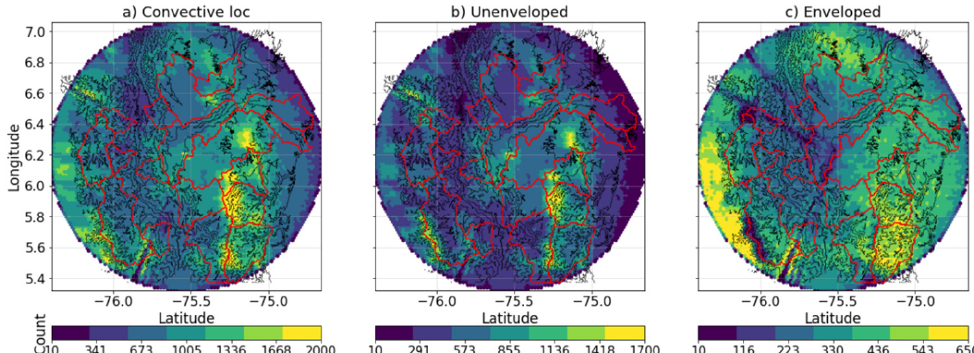
Figure 9. Two-dimensional histogram of convective centroid localization inside the radar region. ( a ) Total convective systems. Figures ( b , c ) correspond to unenveloped and enveloped systems, respectively. The black lines are topographical contour lines representing increments of 1000 m .